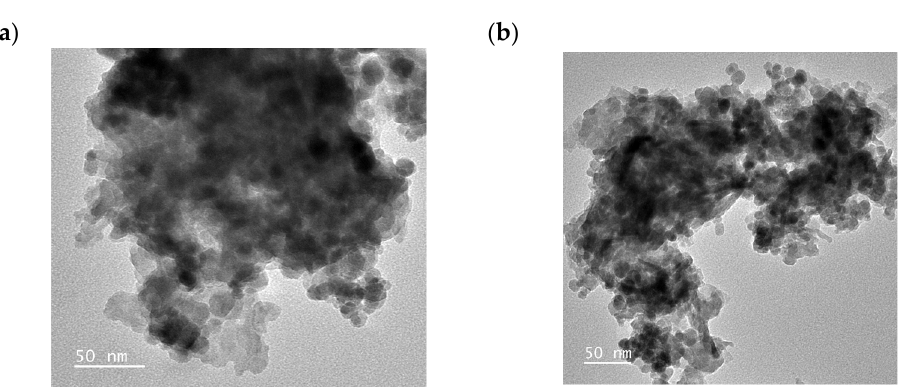
Figure 9. TEM images of a SPION/HAp nanocomposite sample containing ( a ) 80% and ( b ) 90% of SPIONs.